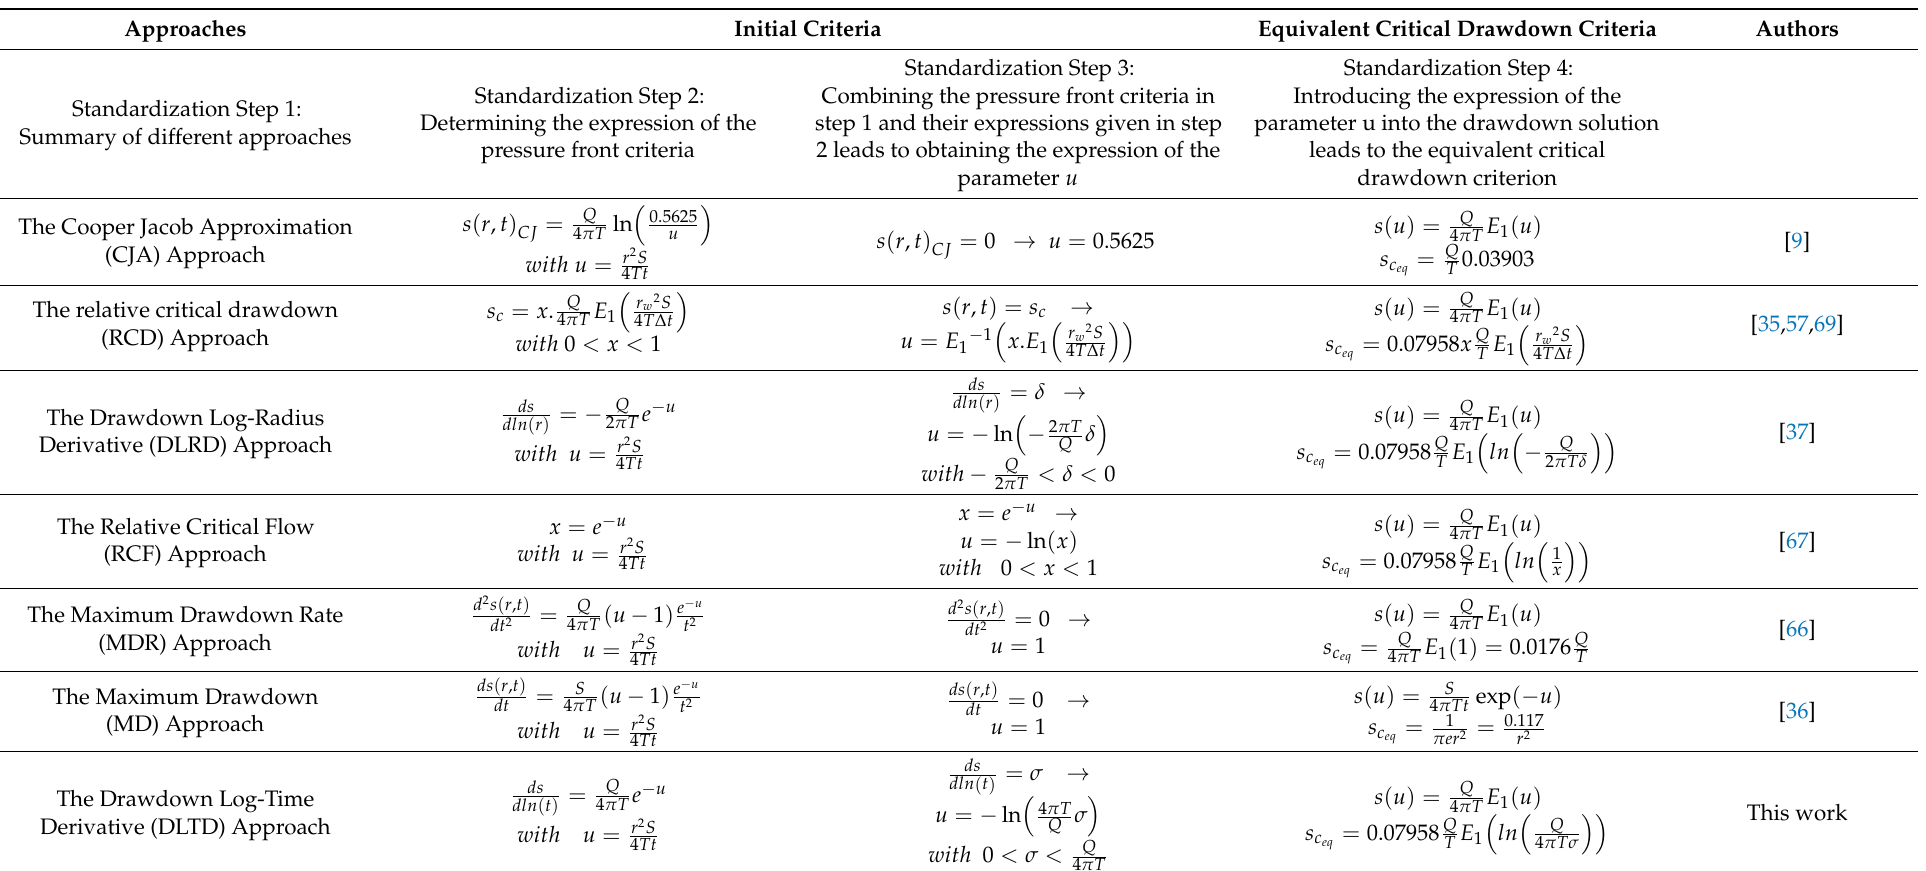
Table 2. Standardization of the criteria used in the different methods. (The steps 1 to 5 indicate the operation used to standardize the criteria of the different